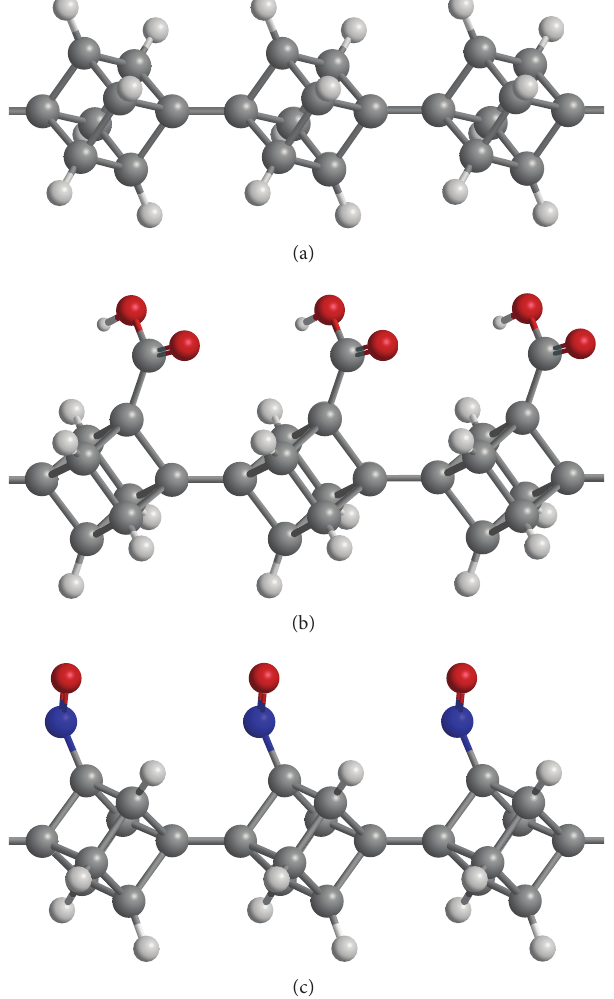
Figure 1: Fragments of the chemically functionalized cubane-based chains studied: (a) pristine chain; (b) COOH-functionalized chain; (c) NO-functionalized